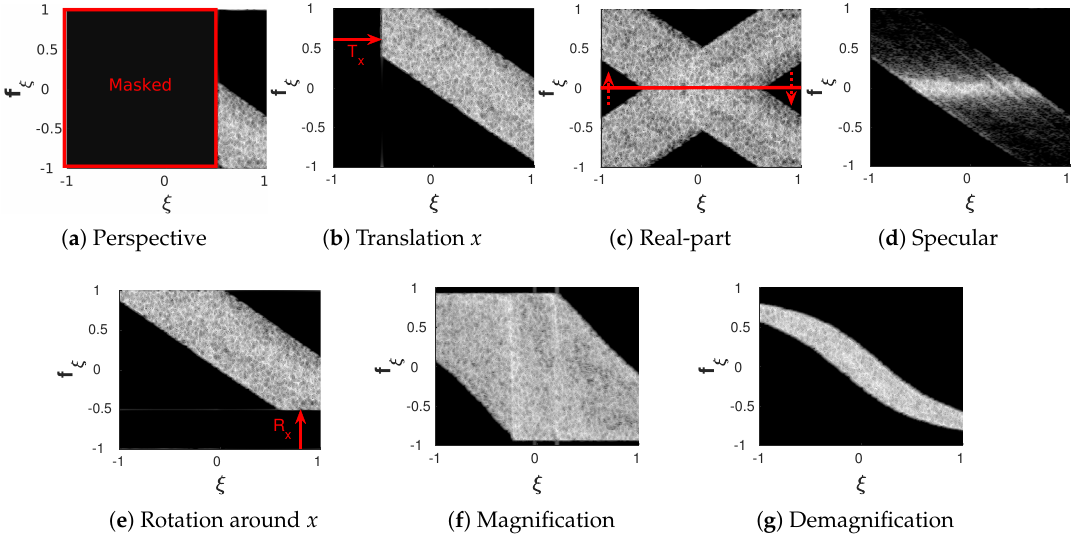
Figure 12. Phase space visualizations of 1D cross-sections of the hologram displayed in Figure 9 after undergoing various manipulations discussed in separate sections below. ( d ) shows the ”Earth8KS“ from INTERFERE-II database [46], which scatters specularly instead of diffuse. ( f , g ) are transversal de-/magnifications of the object shown in Figure